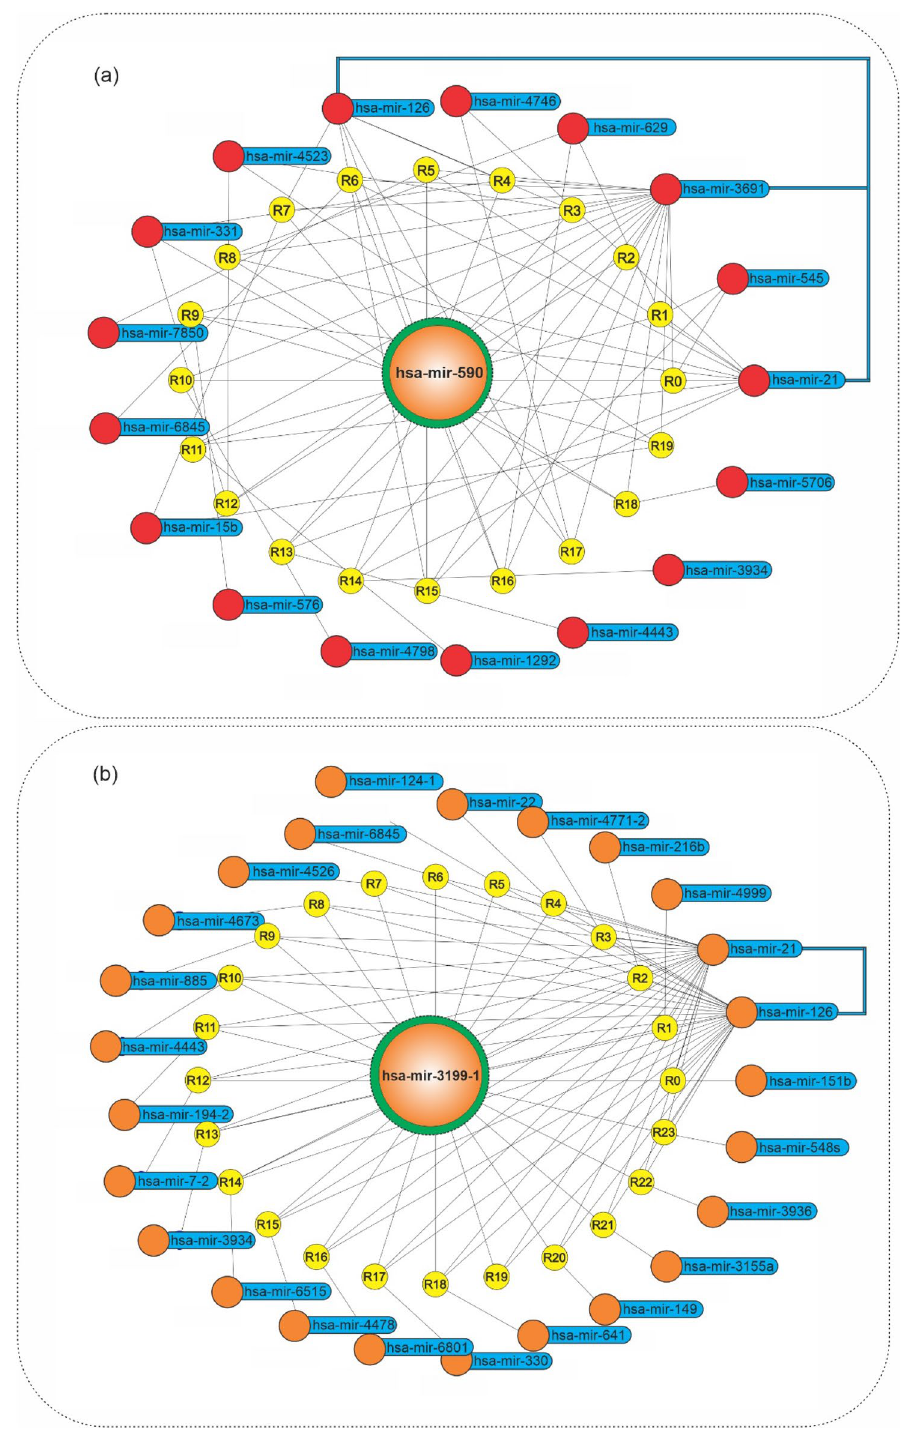
Figure 3. Graph network of has-mir-590 and has-mir-3199-1 in HCC. Graph network of ( a ) has-mir-590 (with lift > 1.14) and ( b ) has-mir-3199-1 (with lift > 1.126) related association rules, in which the has-mir-590 and has-mir-3199-1, their rules, and their related miRNAs were presented, by orange, yellow, and blue colors, respectively. Python programming language (version 3.9) and Matplotlib library (version 3.6.0) were used to draw the plots, all of them are open